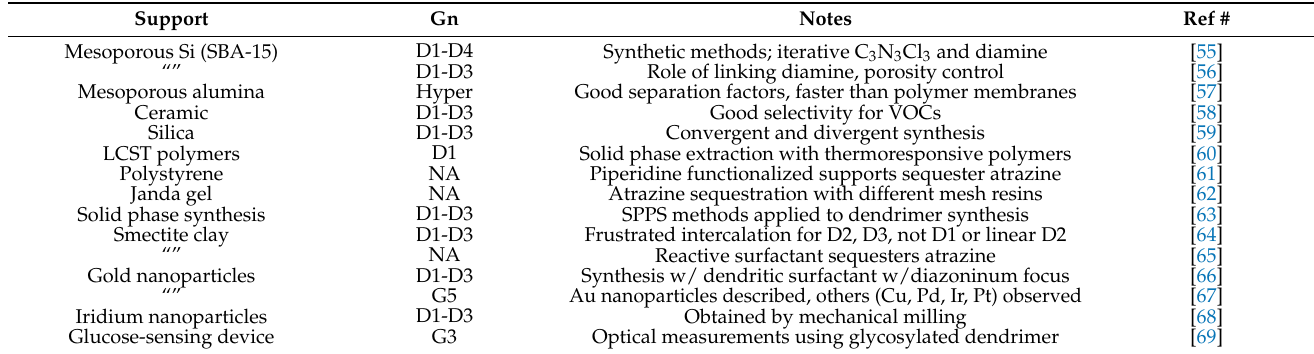
Table 5. Solid supports and triazine